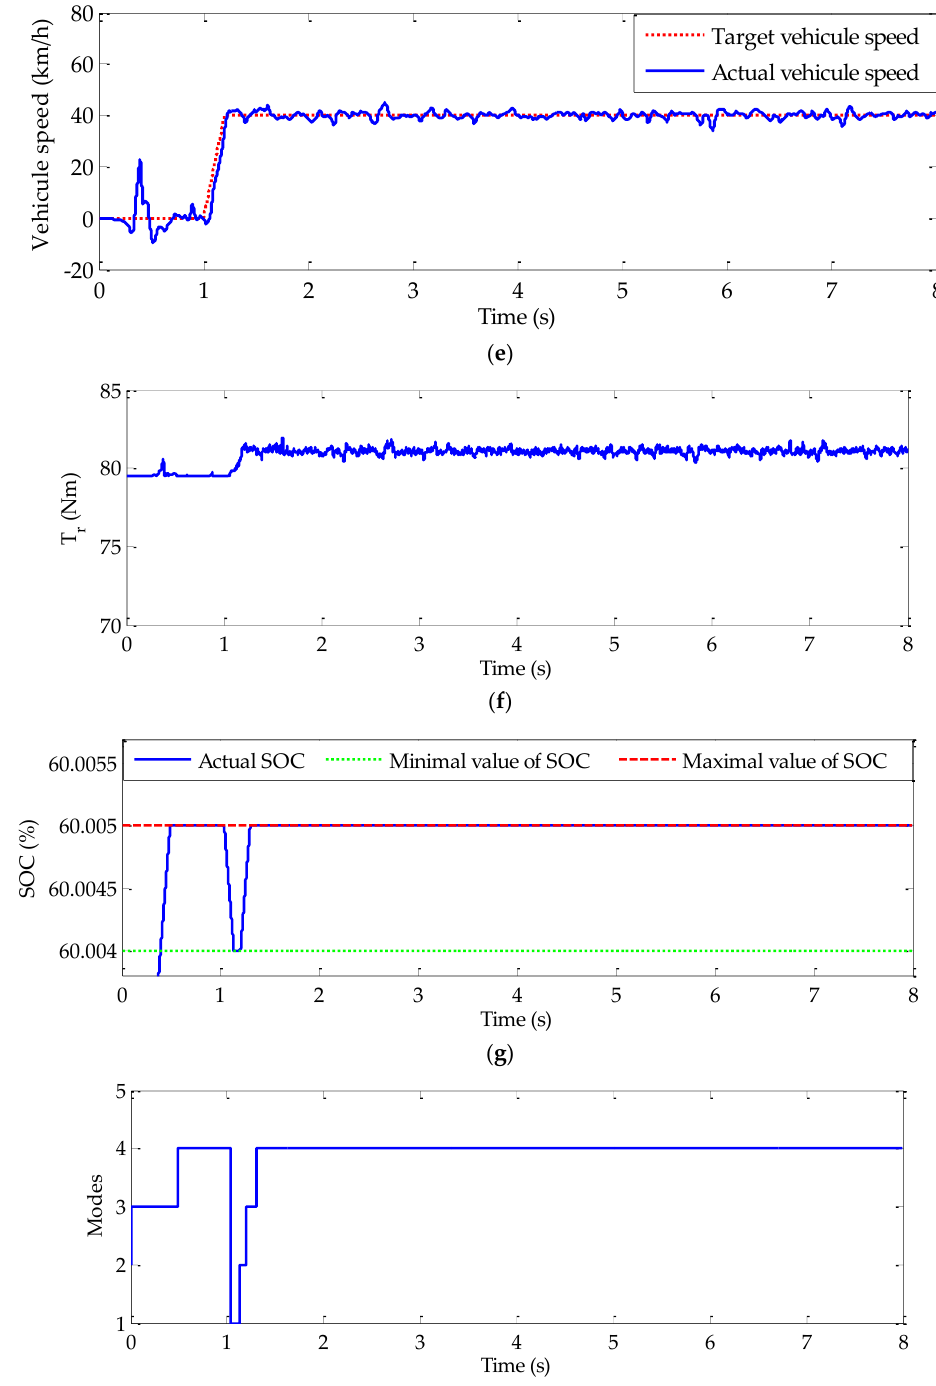
Figure 11. Simulation results under quick response: ( a ) radiation trajectory, ( b ) temperature trajectory, ( c ) PV generator power, ( d ) DC-link voltage, ( e ) vehicle speed, ( f ) load torque, ( g ) battery state of charge, and ( h ) operating mode.